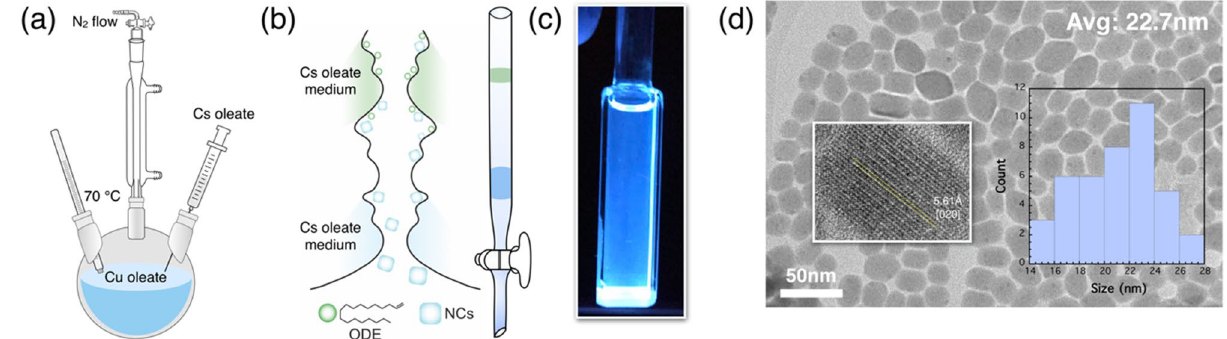
Figure 1. ( a ) Schematic of hot-injection process, ( b ) schematic of purification process, ( c ) image of GPC- purified colloid, and ( d ) TEM image of NCs after GPC purification with d -spacing and histogram of particle